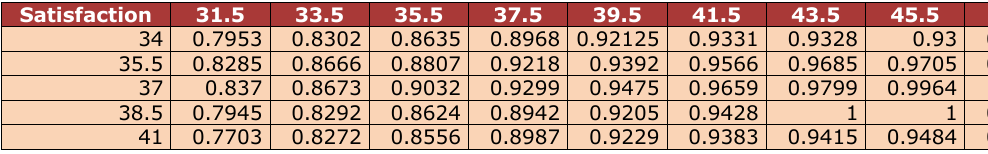
Table 8. Satisfaction of Nanchang-Jiujiang Expressway